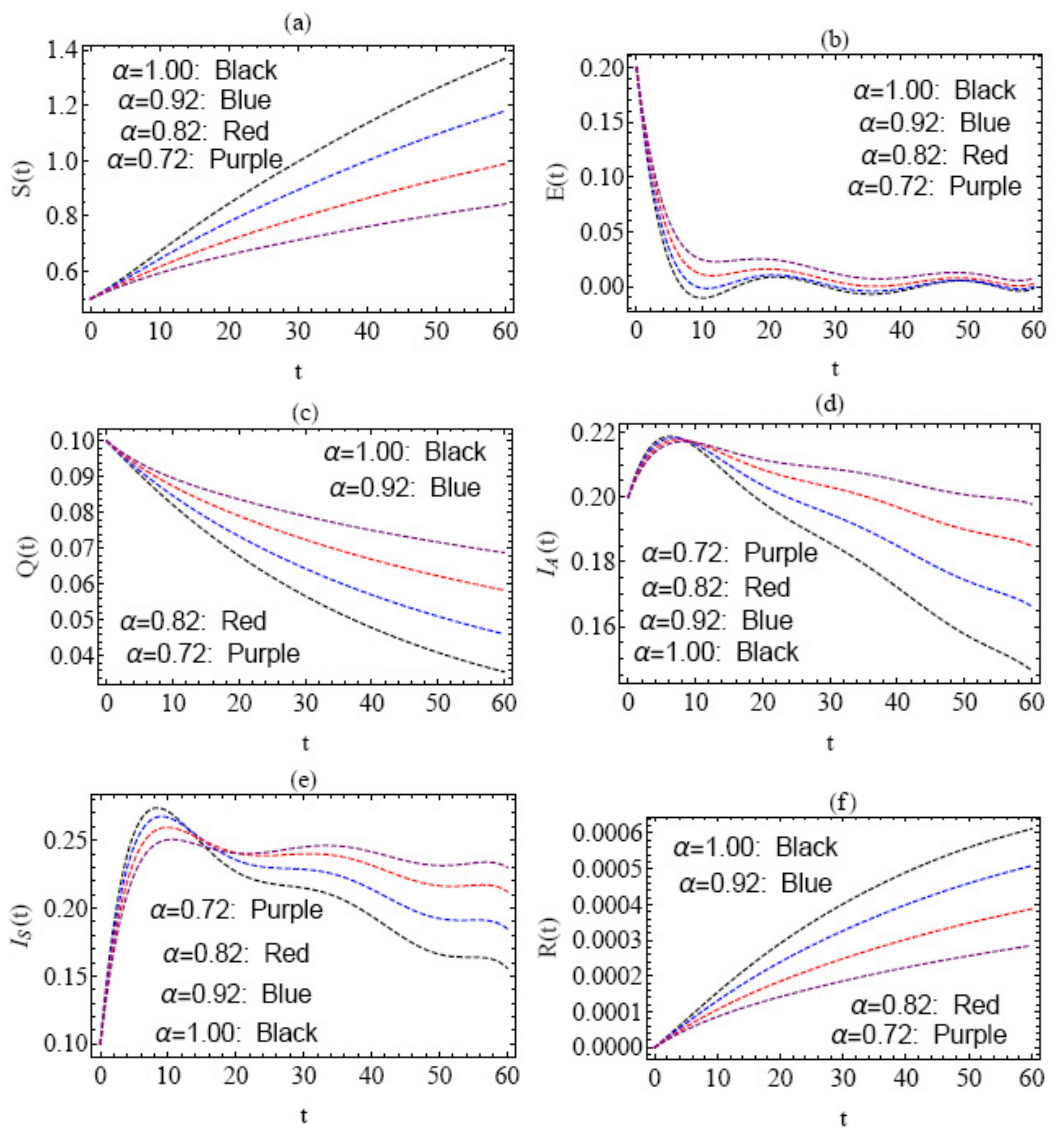
Figure 3. Behavior of the approximate solution via different values of α . ( a – f ) S ( t ) , E ( t ) , Q ( t ) , IA ( t ) , IS ( t ) , R ( t )